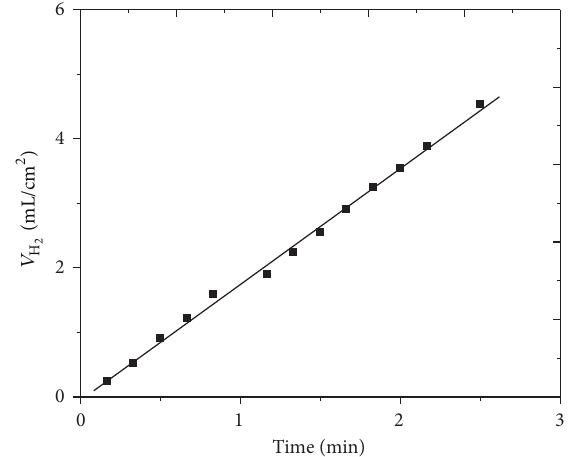
versus time for corrosion H 2